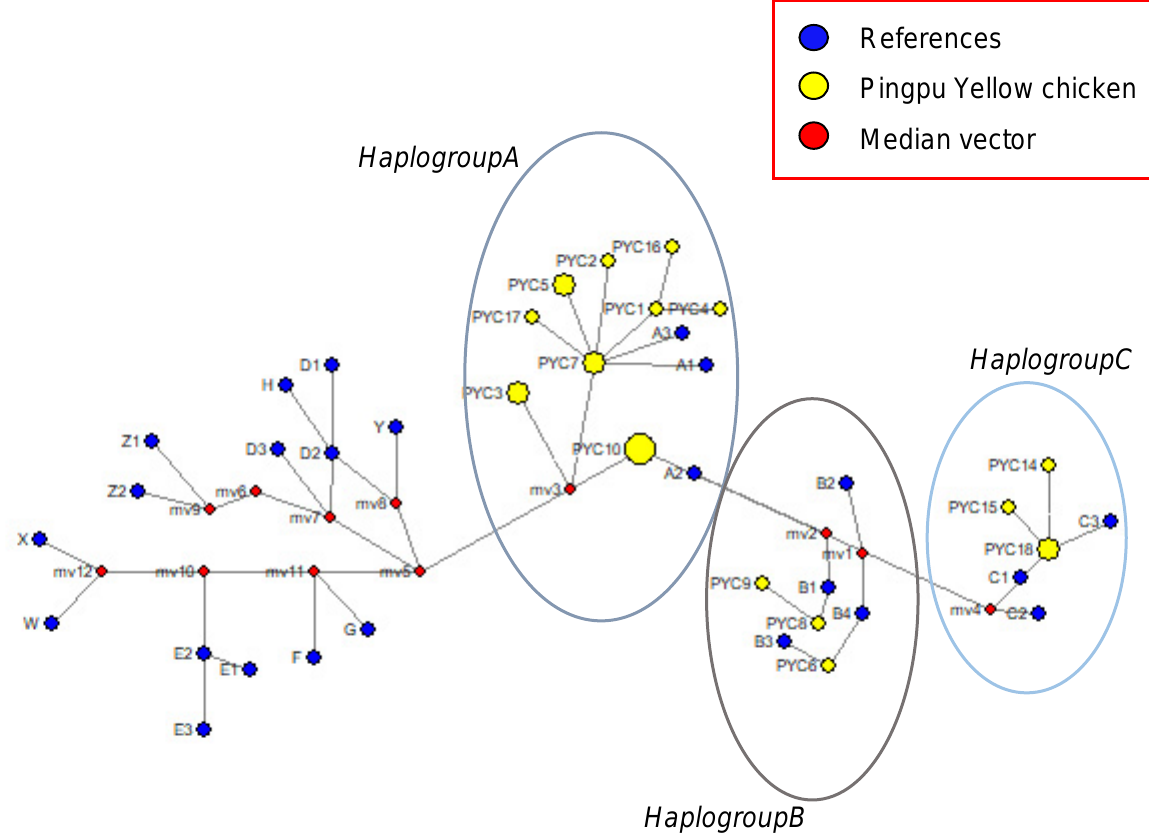
Figure 5. Median-joining network of chicken mtDNA D-loop